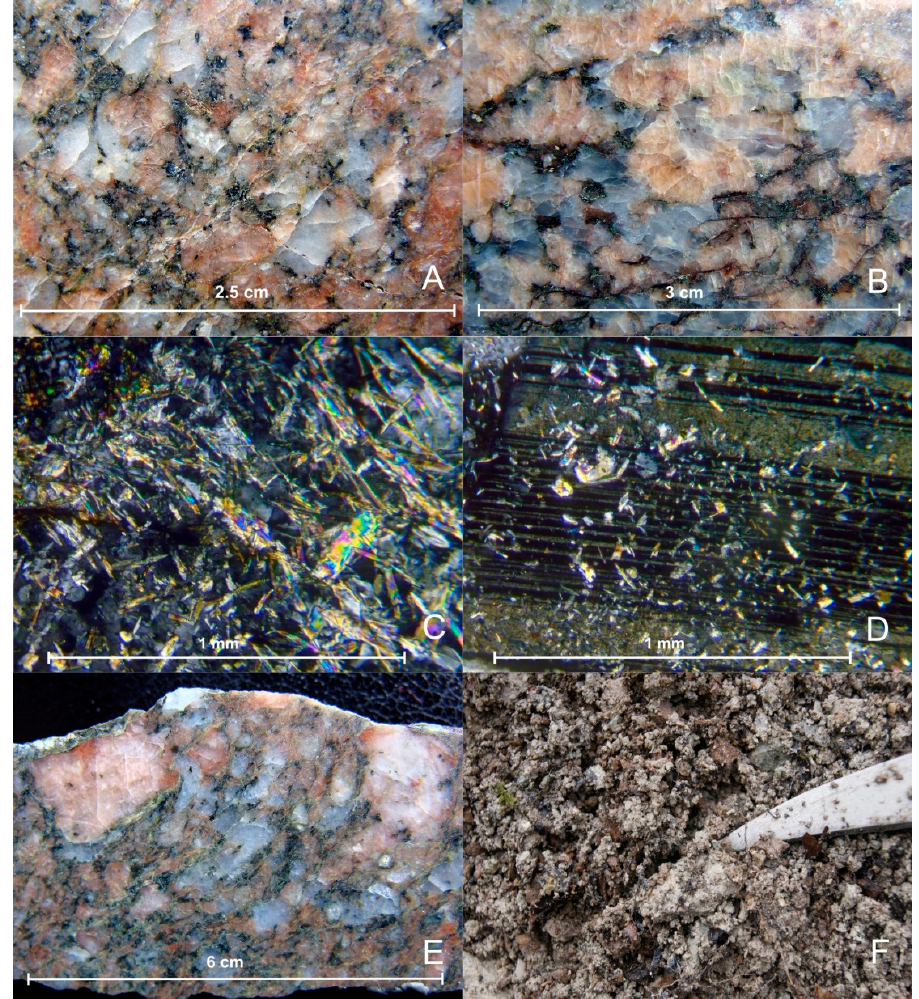
Figure 2. Samples from Mezdreja mine and Gabrovnica mine areas. ( A ) Granite from the vicinity of the Mezdreja mine portal; ( B ) granite form the Gabrovnica mine dump; ( C ) white mica developed in a granite sample from Mezdreja; ( D ) white mica developed in a granite sample from Ganbrovnica; ( E ) gabbroid with large pink K feldspar; ( F ) material from the Mezdeja mine dump.